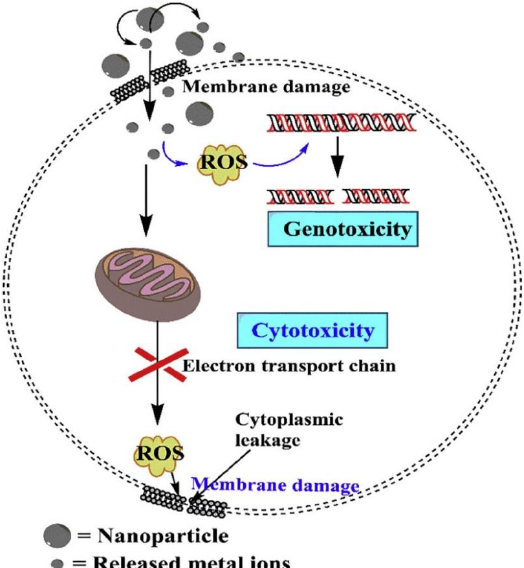
Figure 12. Antibacterial mechanisms of ZnO-Se nanocomposites with visible light illumination. Reproduced with permission from ref. [97]. Copyright © 2020, Elsevier.